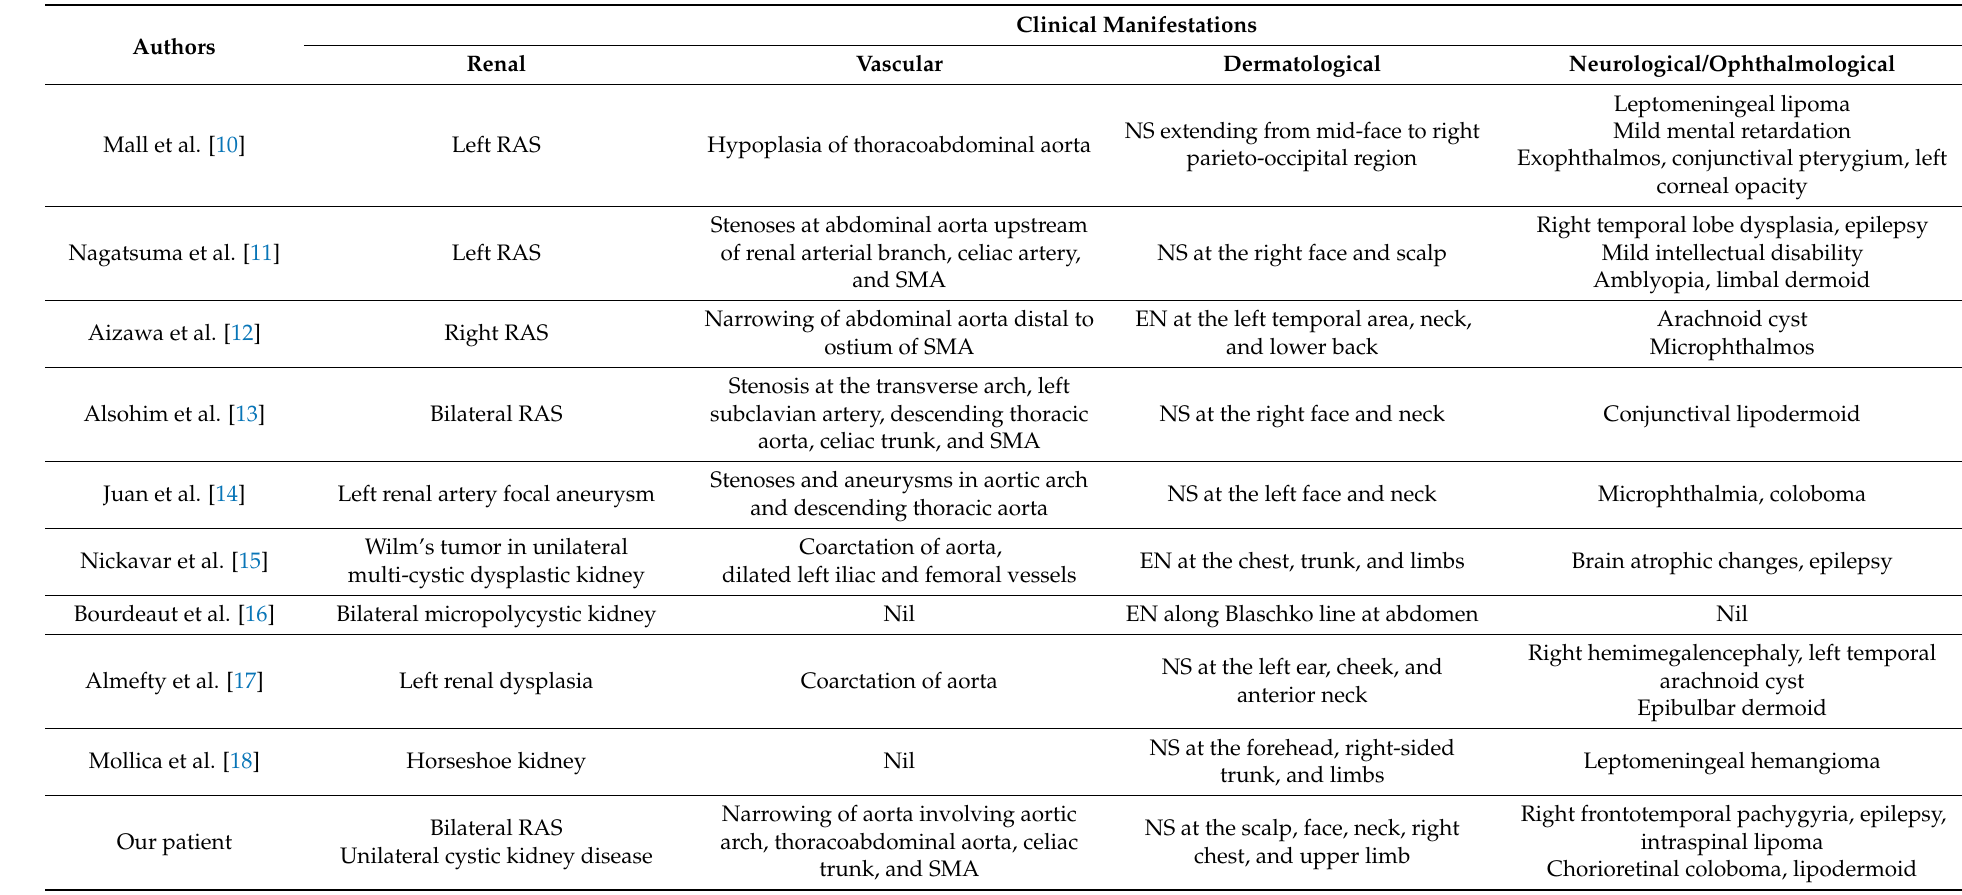
Table 1. Summary of the associations between epidermal nevus/nevus sebaceous and renal